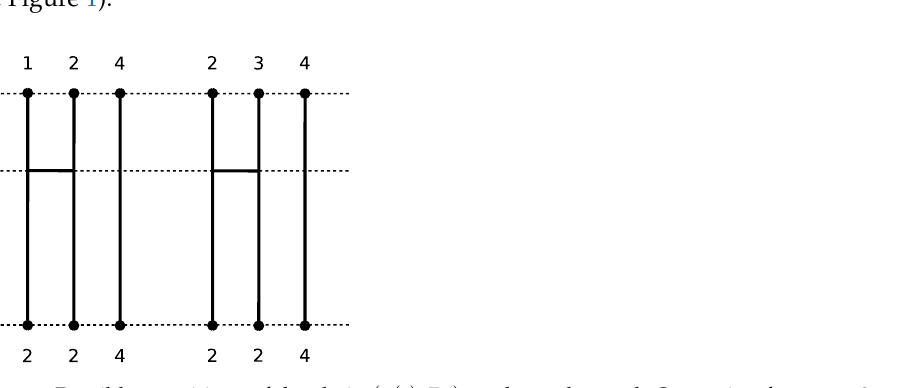
Figure 1. Possible transitions of the chain ( a ( t ) , P a ) on the cycle graph C 4 starting from a = 2 e 2 + e 4